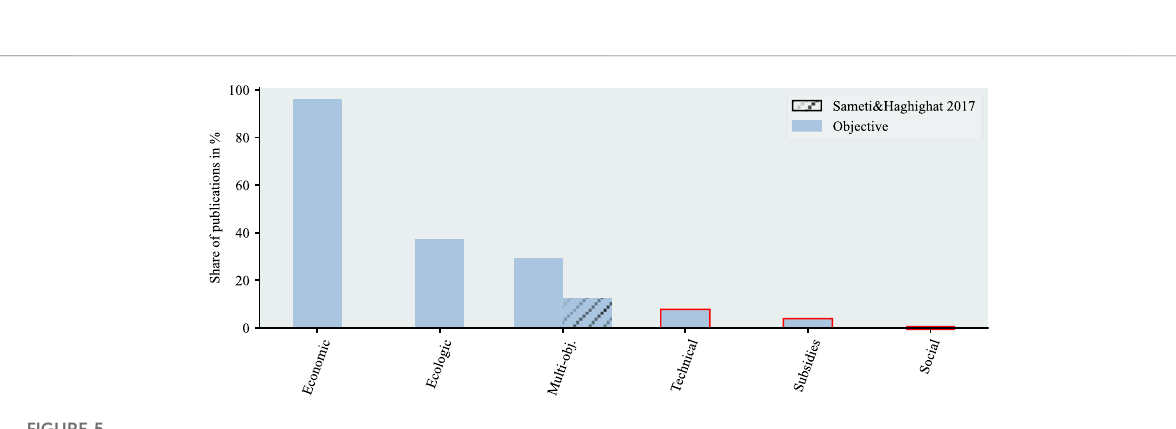
FIGURE 5 Literature distributionfor thesupercategoryobjective withacomparisonofmulti-objectivewith (Sametiand Haghighat, 2017);lownumbersof publications are marked red as an indication of a potential research